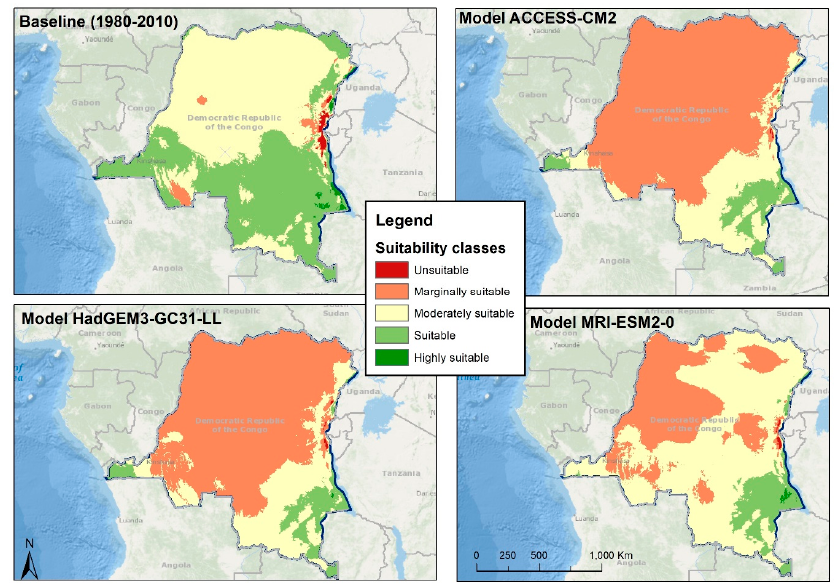
Figure 3. Maize climate suitability under climate change conditions (ssp585) for 2061–2080 in DRC. Predicted Climate Suitability for Common Bean under Climate Change Condi- tions in DRC. Except for the highlands of eastern DRC and part of Katanga, climate-based suitability for common beans is very marginal in DRC. Moreover, only the eastern high- lands will remain suitable with climate change, and the Katanga side will become mar- ginal. This drastic situation will increase if the region follows ssp585 scenarios (Figure 4). Therefore, it will increase farmers’ vulnerability if they continue cultivating common beans as one of the major crops, as it is the case in eastern DRC. Regarding spatial distri- bution, all regions are currently similar in land suitability.